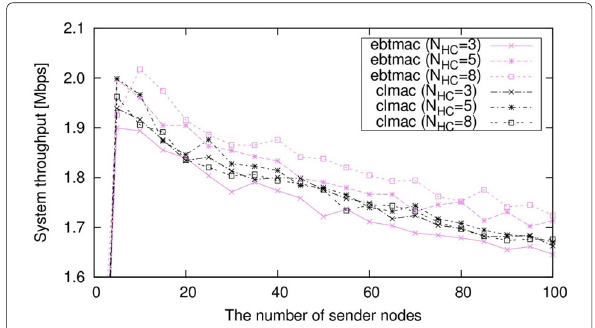
Fig. 13 Throughput comparison of eBT-COMAC with the reference [14]